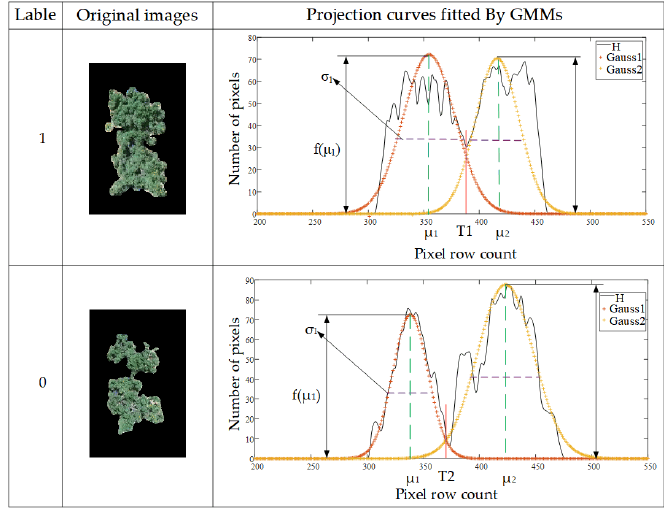
Figure 11. Examples of labeling and the characterizing parameters. Table 2. Examples of the feature parameters and their labels.